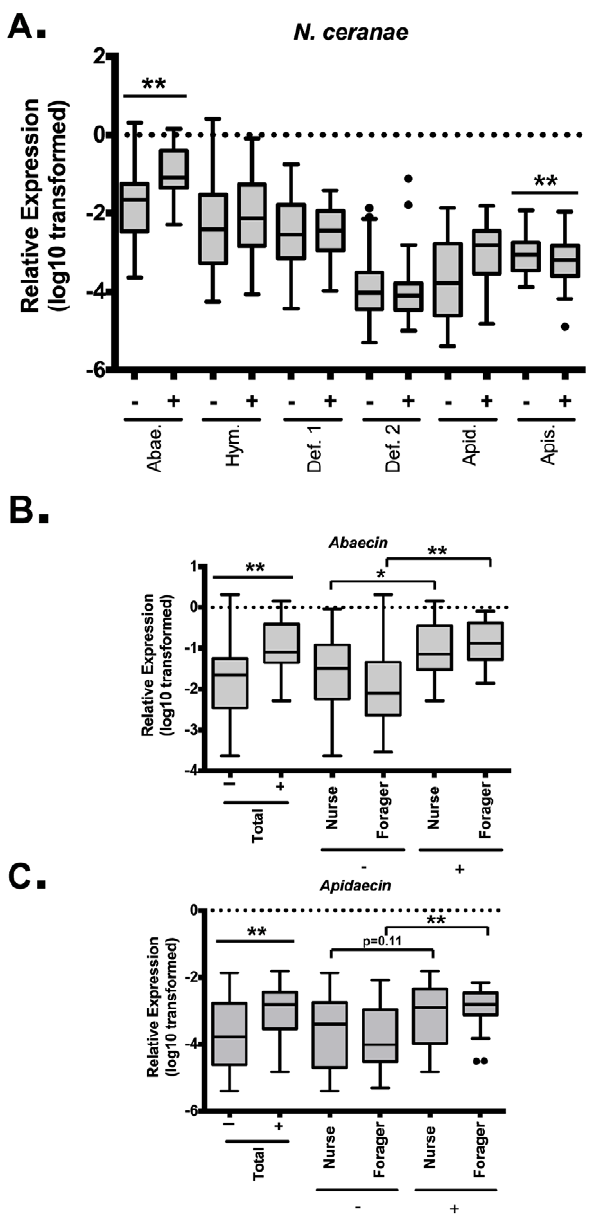
Figure 5. Differences in AMP expression between Nosema infected and non-infected bees are similar in nurse and foragers. Levels of the six honey bee AMPs ( Abaecin (n=91), Hymenoptaecin (n=91), Defensin 1 (n=92), Defensin 2 (n=91), Apidaecin (n=92), and Apisimin (n=92) relative to b -actin in midgut tissue from bees that were positive ( + ) or negative ( 2 ) for Nosema ceranae (A). Levels of Abaecin (B) and Apidaecin (C) relative to b -actin in midgut tissue from bees that were positive ( + ) or negative ( 2 ) for Nosema ceranae for all bees and split into nurses and foragers. Boxes show 1st and 3rd interquartile range with line denoting medians. Whiskers encompass 95% of the individuals. Outliers are denoted with filled circles.